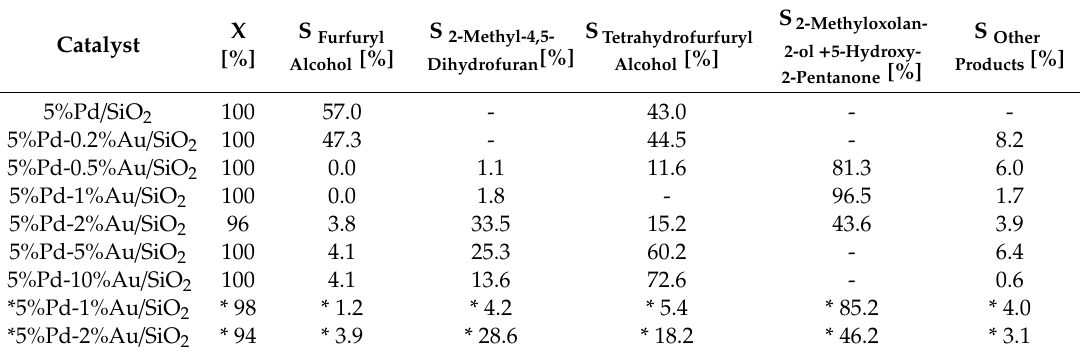
Table 1. Conversion degree of furfural (X, %) and selectivity to all products (furfuryl alcohol, 2-methyl-4,5-dihydrofuran, tetrahydrofurfuryl alcohol, and 2-methyloxolan-2-ol) after 2 h of furfural hydrogenation in water over Pd-Au / SiO 2